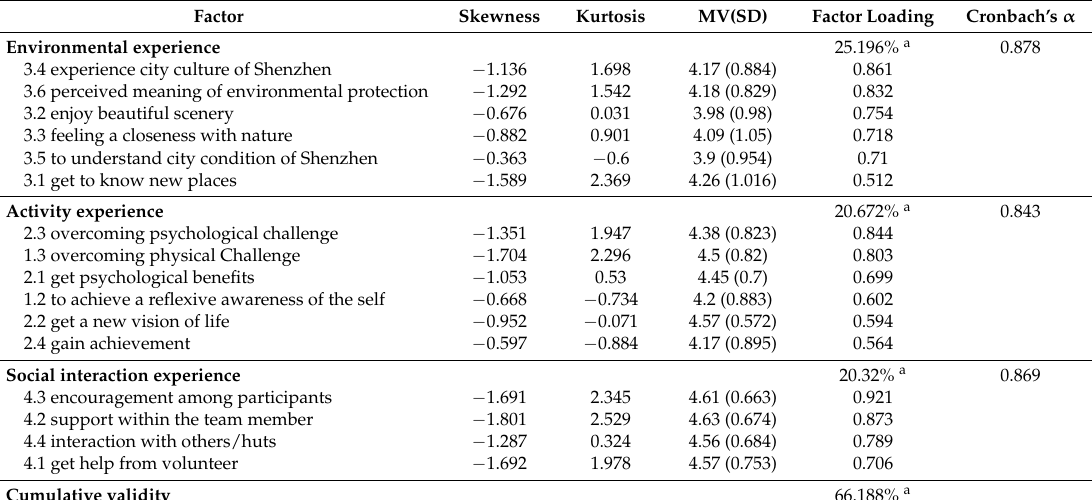
Table 2. Exploratory factor analysis for walking event